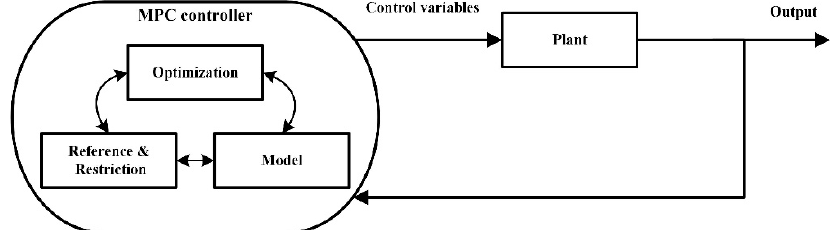
Figure 5. Schematic diagram of MPC.